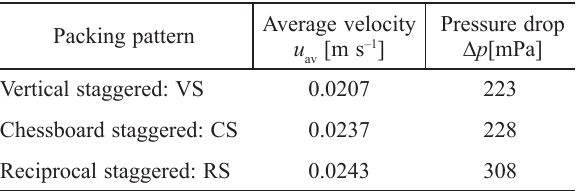
Table 3 – Comparison of average velocity via pressure drop in three packing patterns Packing